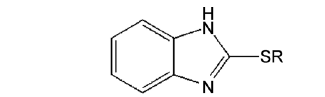
Fig. 9 The structural formula of the compound.